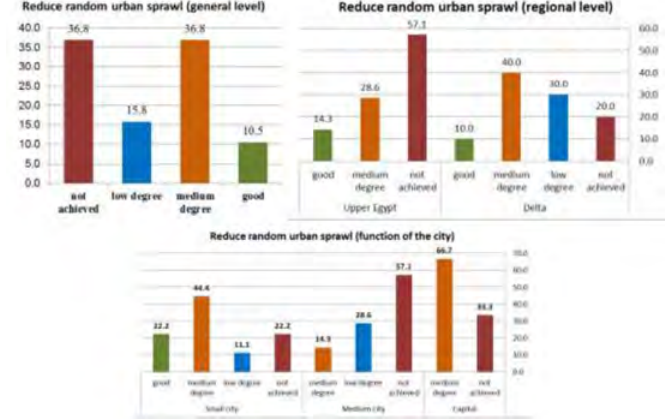
Figure 3. Reductionof random urban